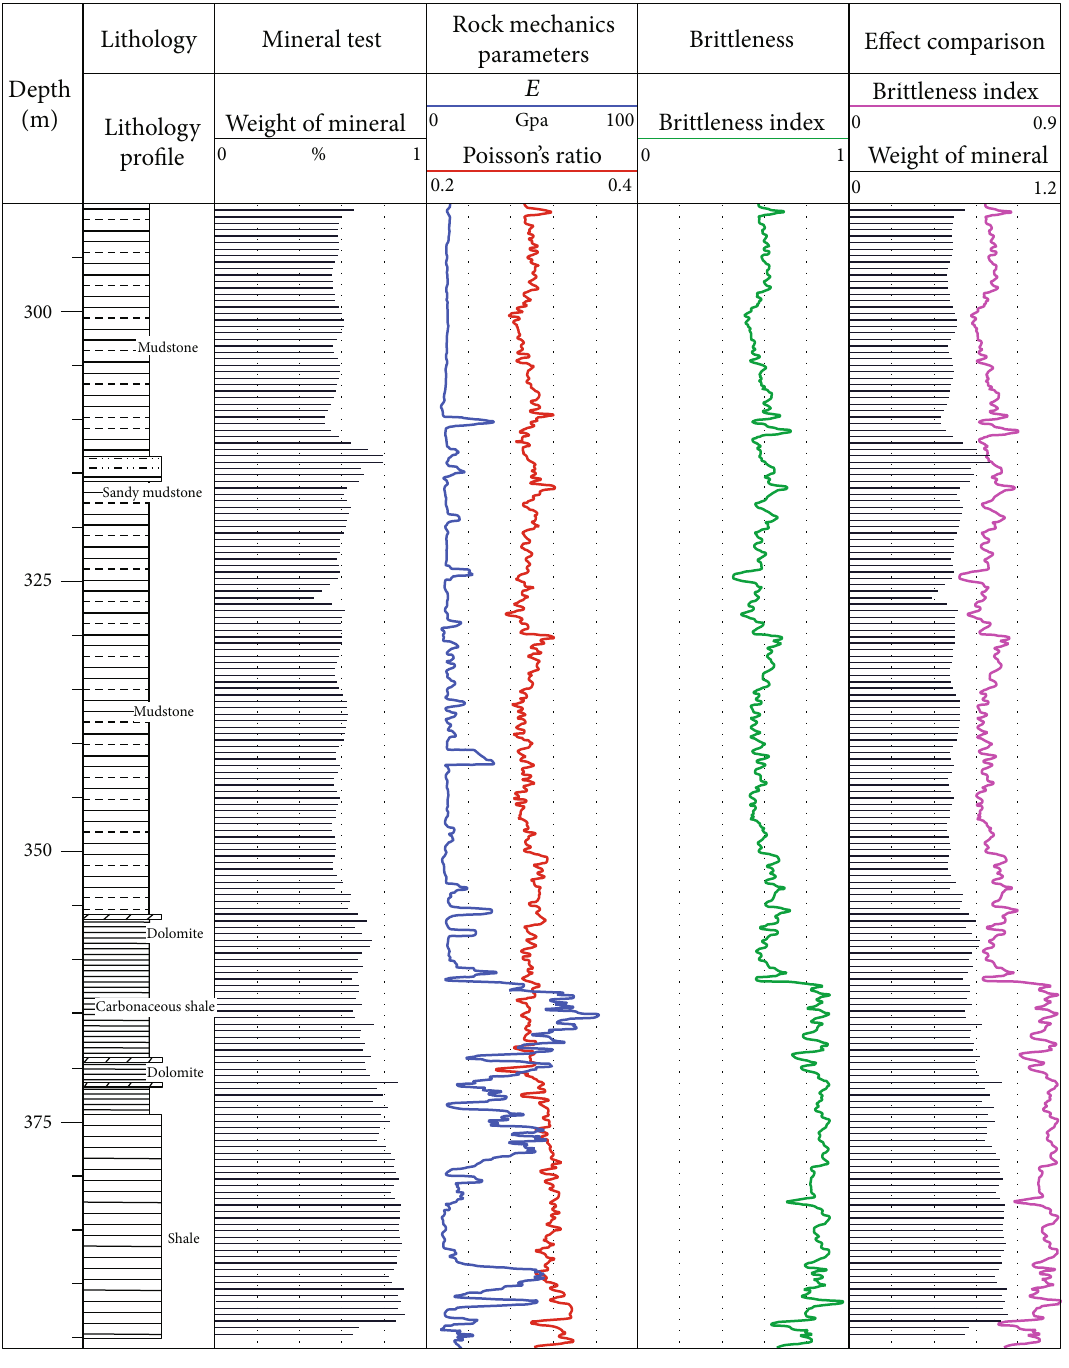
Figure 6: Comparison of di ff erent brittleness indexes for Xike